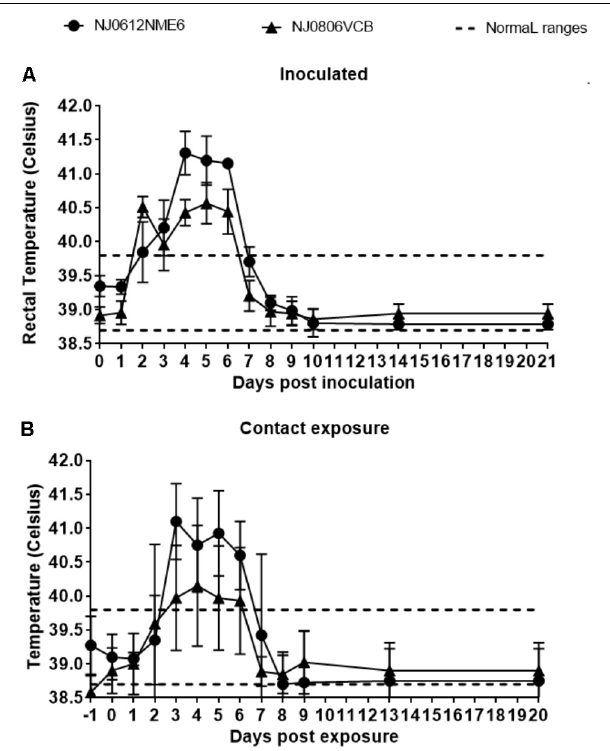
FIGURE 7 | Clinical scores following NJ0612NME6 or NJ0806VCB inoculation. Two independent groups of four pigs were inoculated with 1 × 10 7 TCID 50 and then allowed to co-mingle with four contact pigs at 24 hpi. Pigs were examined daily for the presence of lesions in the snout, mouth, lips, feet, and the cumulative clinical scores are given for the (A) inoculated and (B) contact exposure pigs. In all cases values represent means and standard deviations for each group of